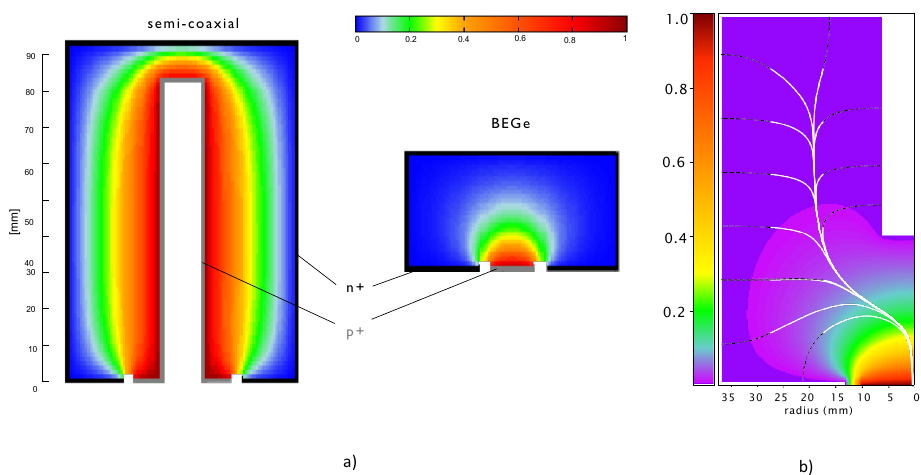
Figure 7. ( a ) Cross-sections of a GERDA coaxial (left) and BEGe (right) detector with an overlay of the corresponding weighting potentials. Figure published by Science, 2019 [6]. ( b ) Weighting potential for an IC detector. Figure published by EPJC, 2021